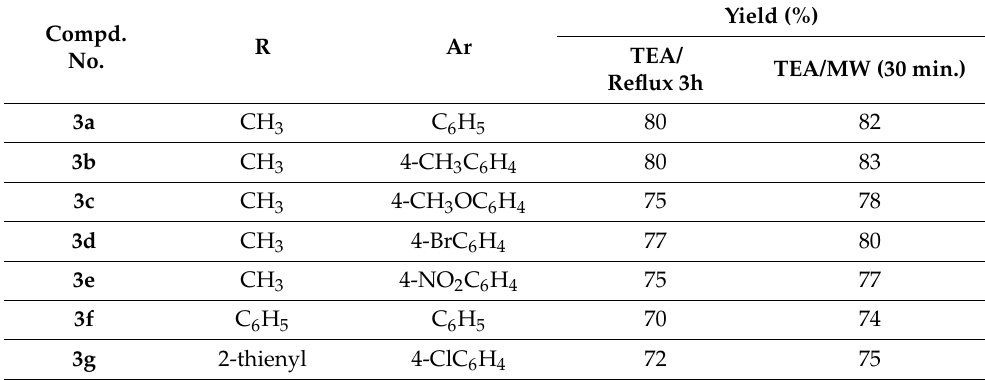
Table 2. An illustration of the comparative yield (in percentage) for 3a – g thiazoles. Here, Triethy- lamine was used as the primary reinforcer under different conditions.